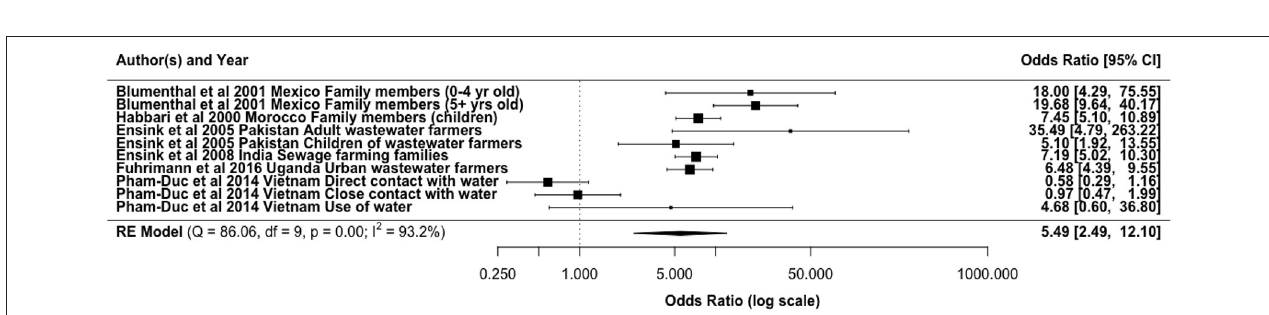
FIGURE 3 | Odds ratio for exposure to partially treated/untreated wastewater and helminth infections from selected literature.